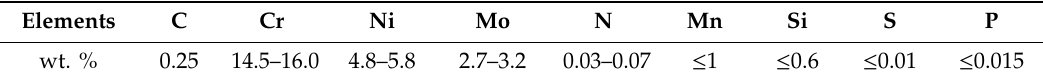
Table 1. Chemical Composition of Transformation-Induced Plasticity (TRIP) Steel. Elements